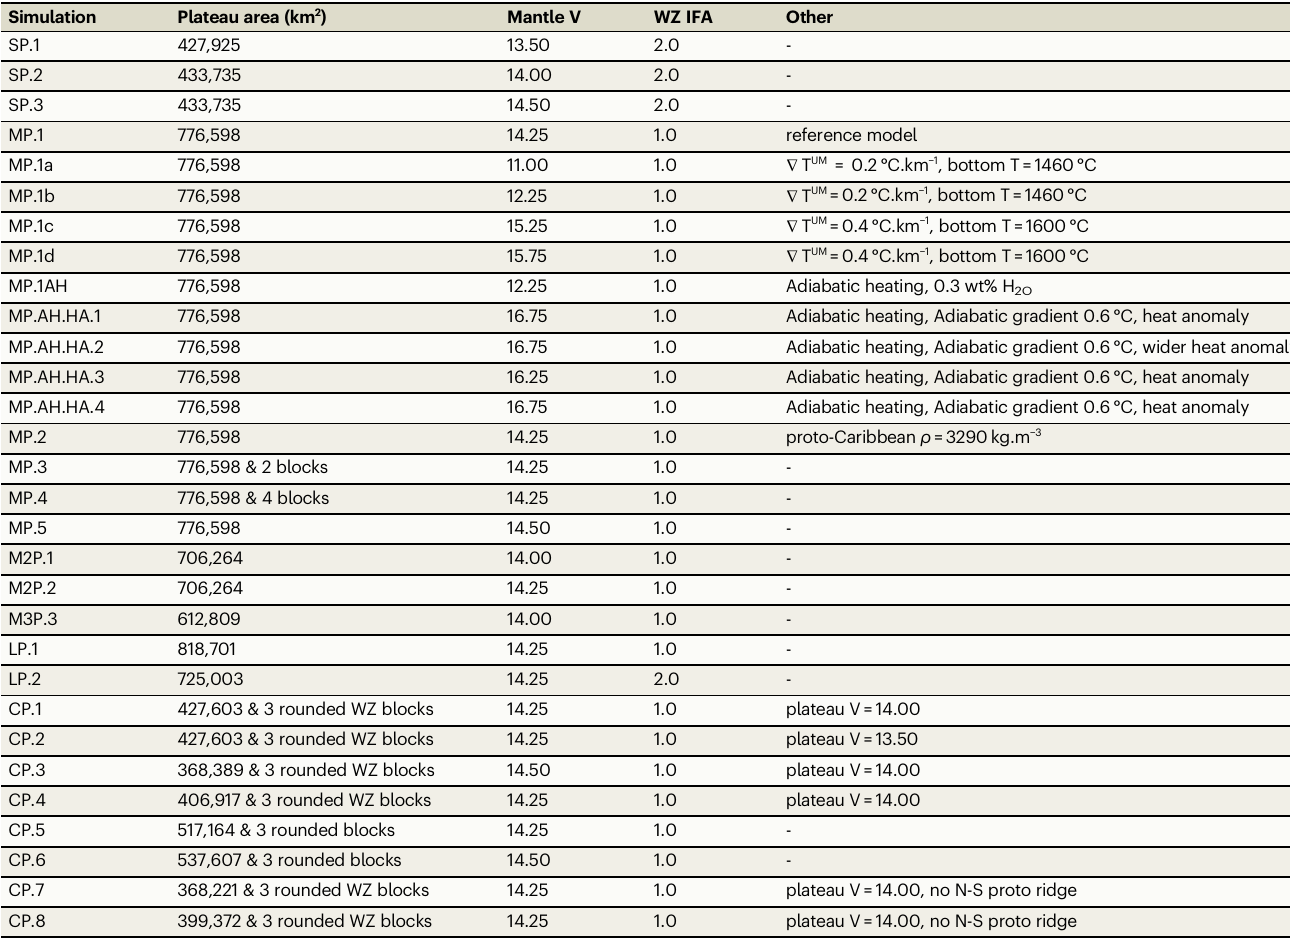
Table 2 | Investigated